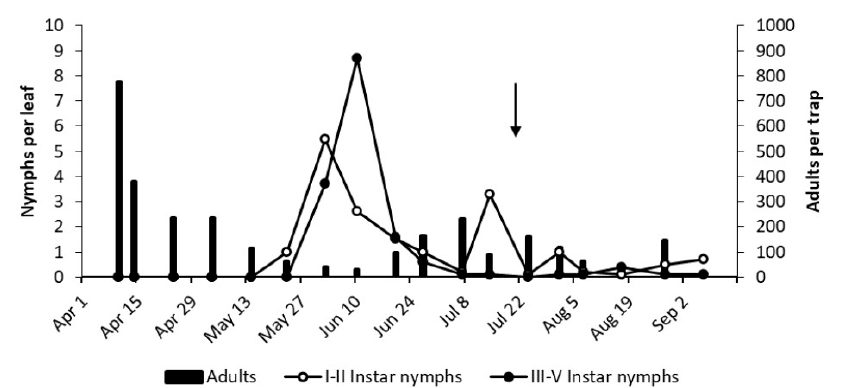
Figure 6. The phenology of E. vulnerata in AO vineyard in the growing season of 2017. Arrow indicates pyrethrins treatment.